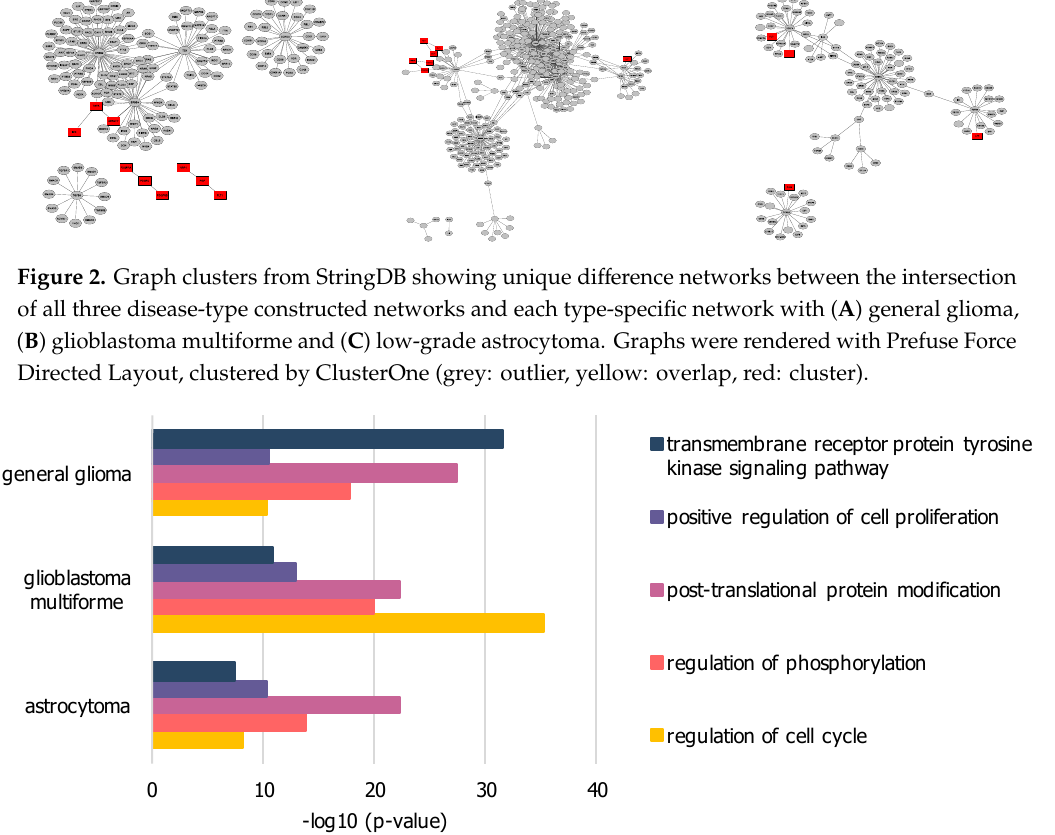
Figure 3. Significant GO-terms within PPI networks of GBM, general glioma and low-grade astrocytoma dissections: based on elevated expression levels of genes associated with GO-term “proliferation”, enriched via BioGRID, difference from merged network intersection; significance expressed as p-value, calculated by BinGO.